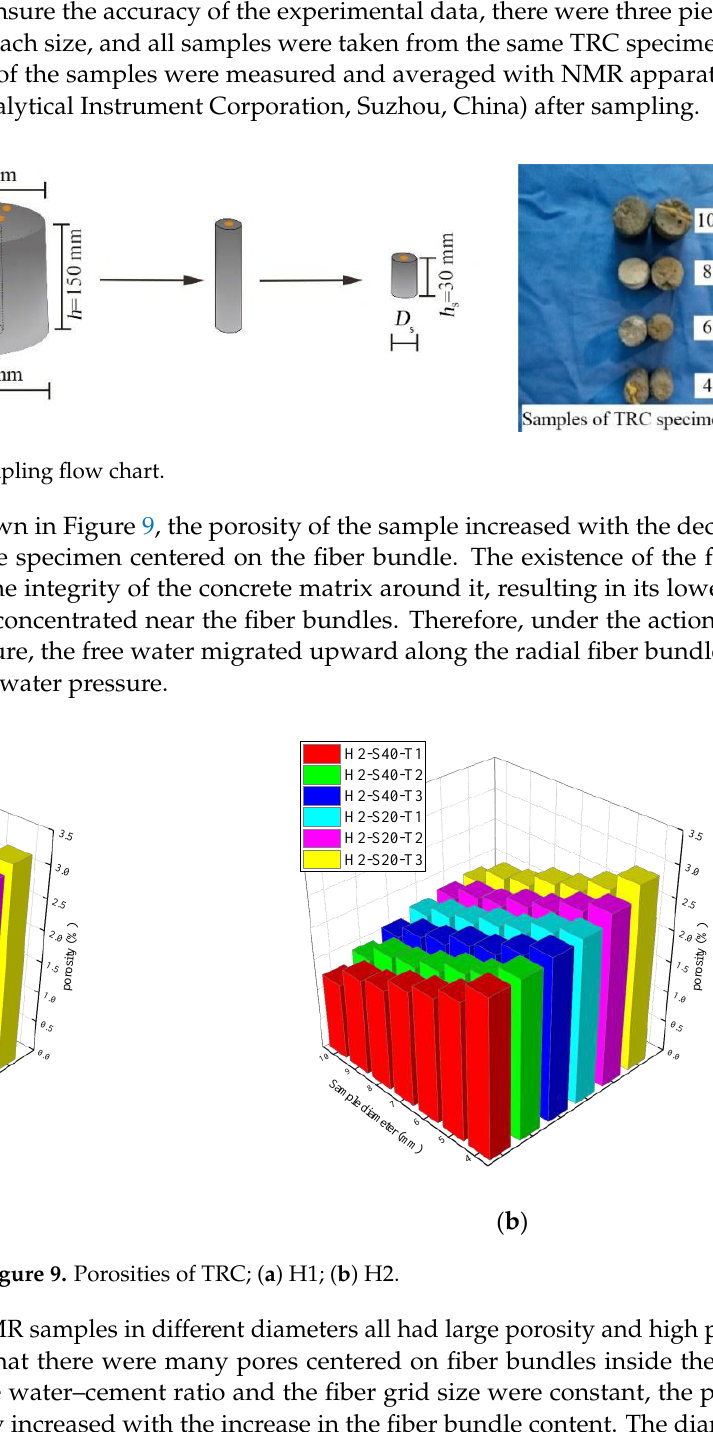
Figure 8. Sampling flow chart.